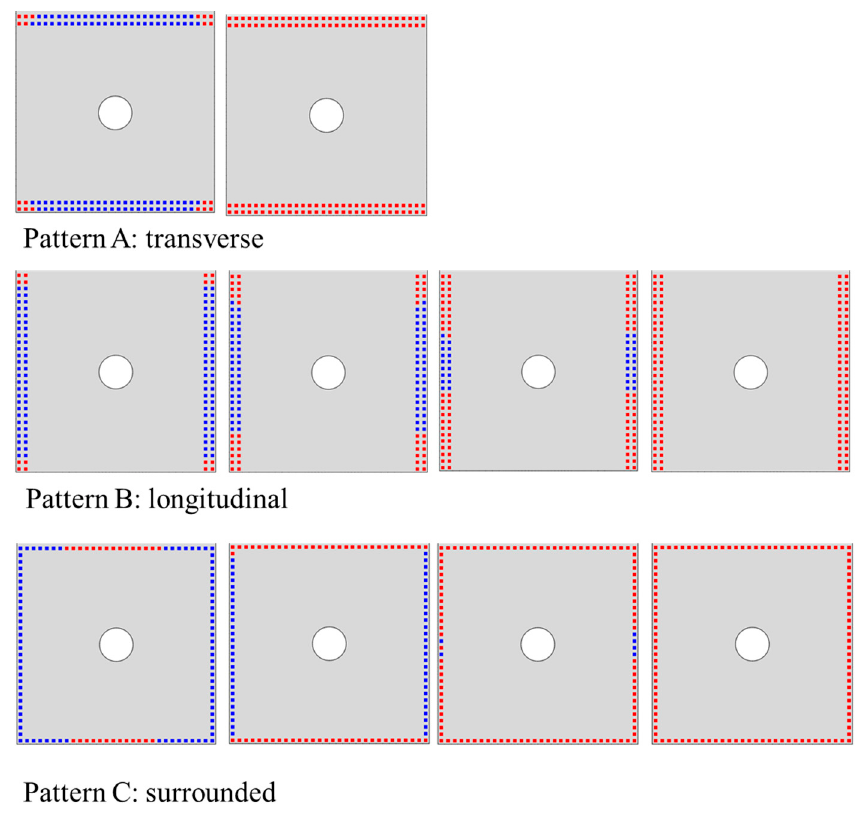
Figure 18. Progressive failure of the deposited SiC matrix in DZA.